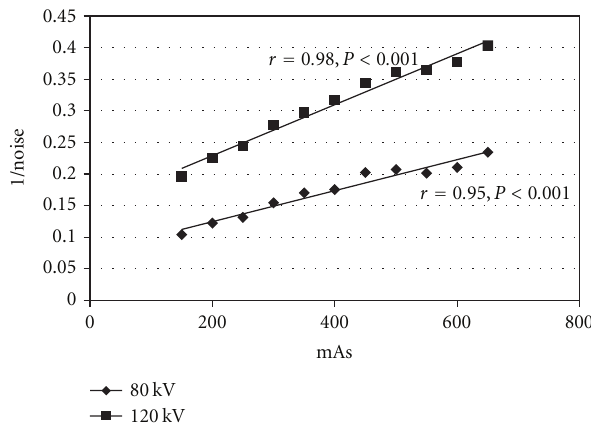
Figure 2: Graph shows inversely correlative between tube current (mAs) and image noise. At identical tube current, image noise obtained at 80 kV is higher than that at 120kV.